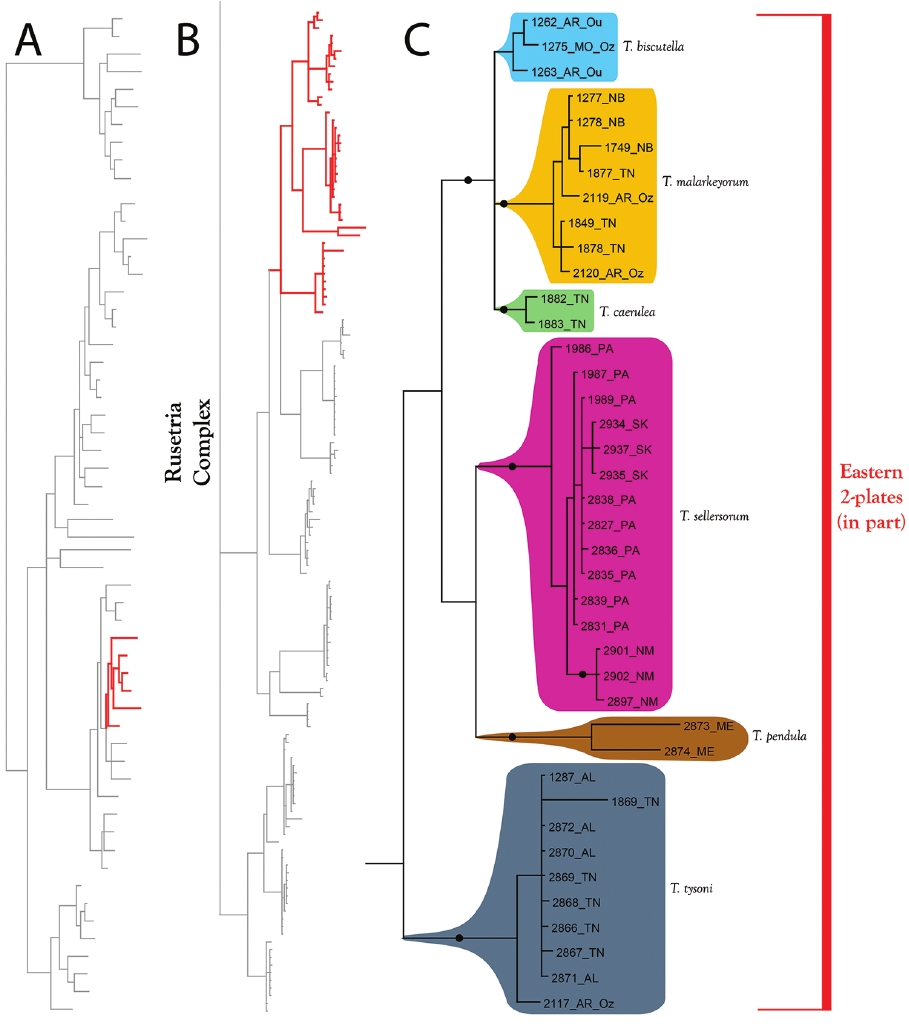
Figure 14. Rusetria Complex (part I). All species are eastern, but note the distribution of T. sellersorum extends into New Mexico and Saskatchewan. A Species guide (overview of 28S+COI analysis from Figure 7–8) B Overview of Rusetria Complex from Figure 9 (COI-only analysis from Figure 9) C Detail of Ruse- tria Complex (in part) from B C Detail of Rusetria Complex (in part) from Figure 9. Colored lineages in A and B correspond to Group names and brackets in C. Dots denote posterior probably of greater than 95%. Taxa are displayed by DNA number and state (U.S.) or territory (Canada)